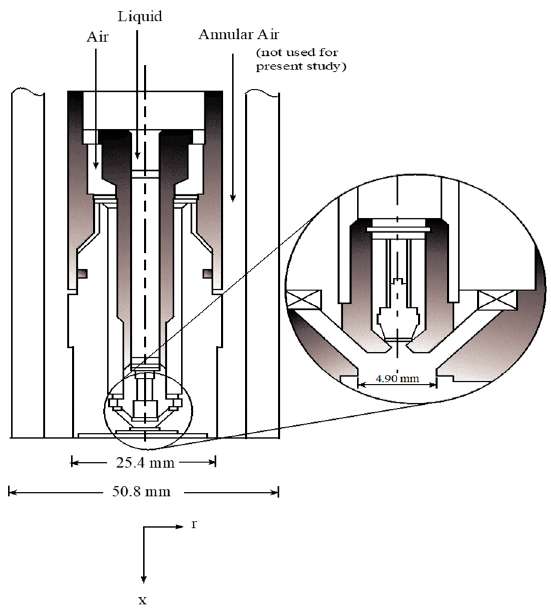
Figure 4. Geometry of the Simplex atomizer.